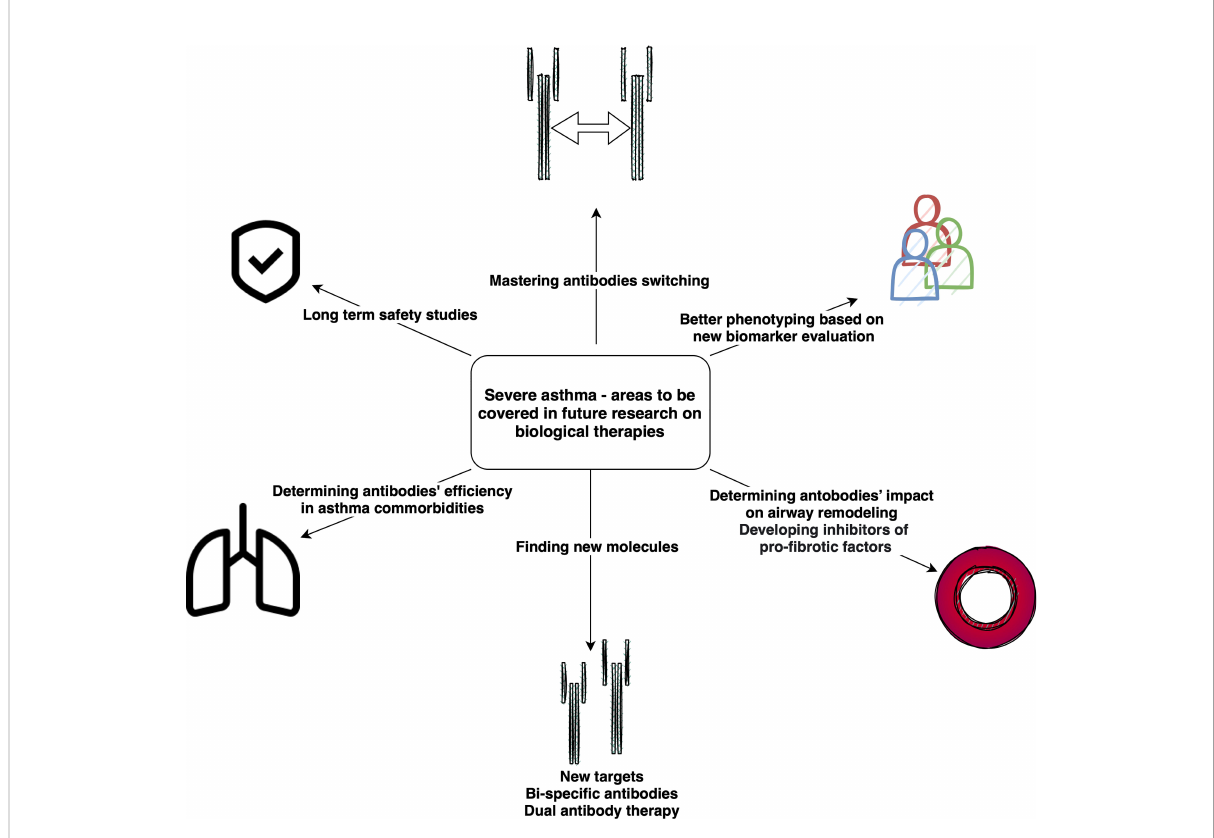
FIGURE 2 Summary on future perspectives in severe asthma